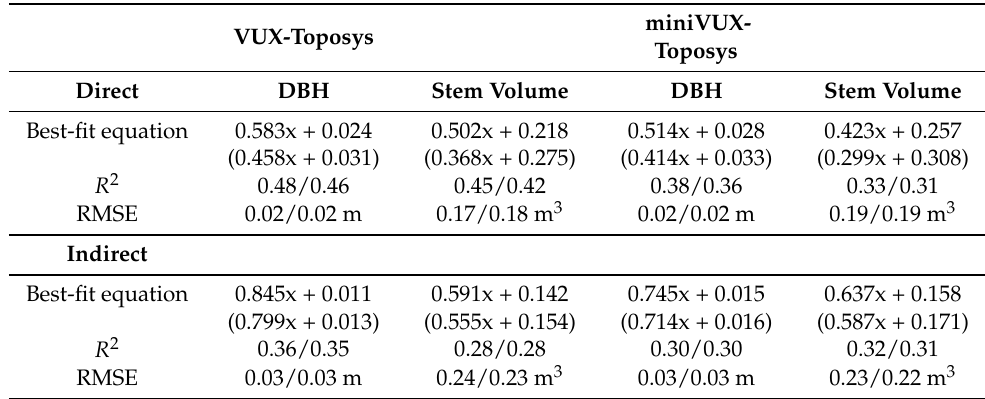
Table 7. The effect of the bias-fixing method. The fixed best fit function is on top of the unfixed one (in parentheses), and the fixed R 2 and RMSE values are on the left-hand side of the slash line. VUX-Toposys